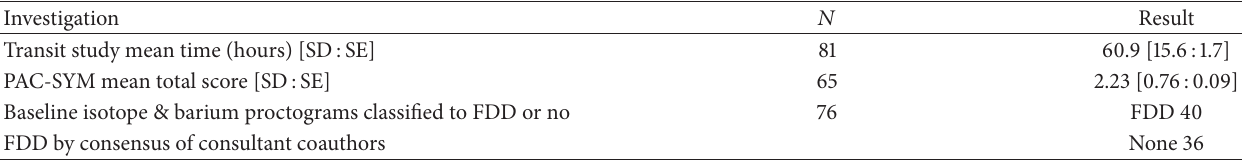
Table 4: Baseline investigations on prospective database (cohort).